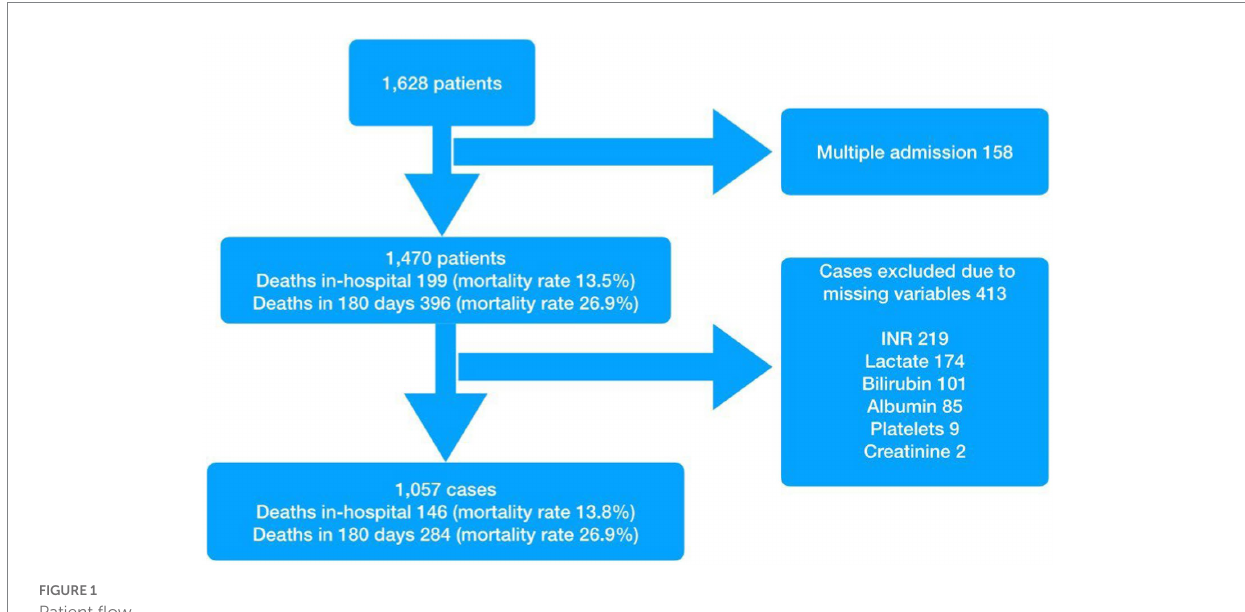
FIGURE 1 Patient